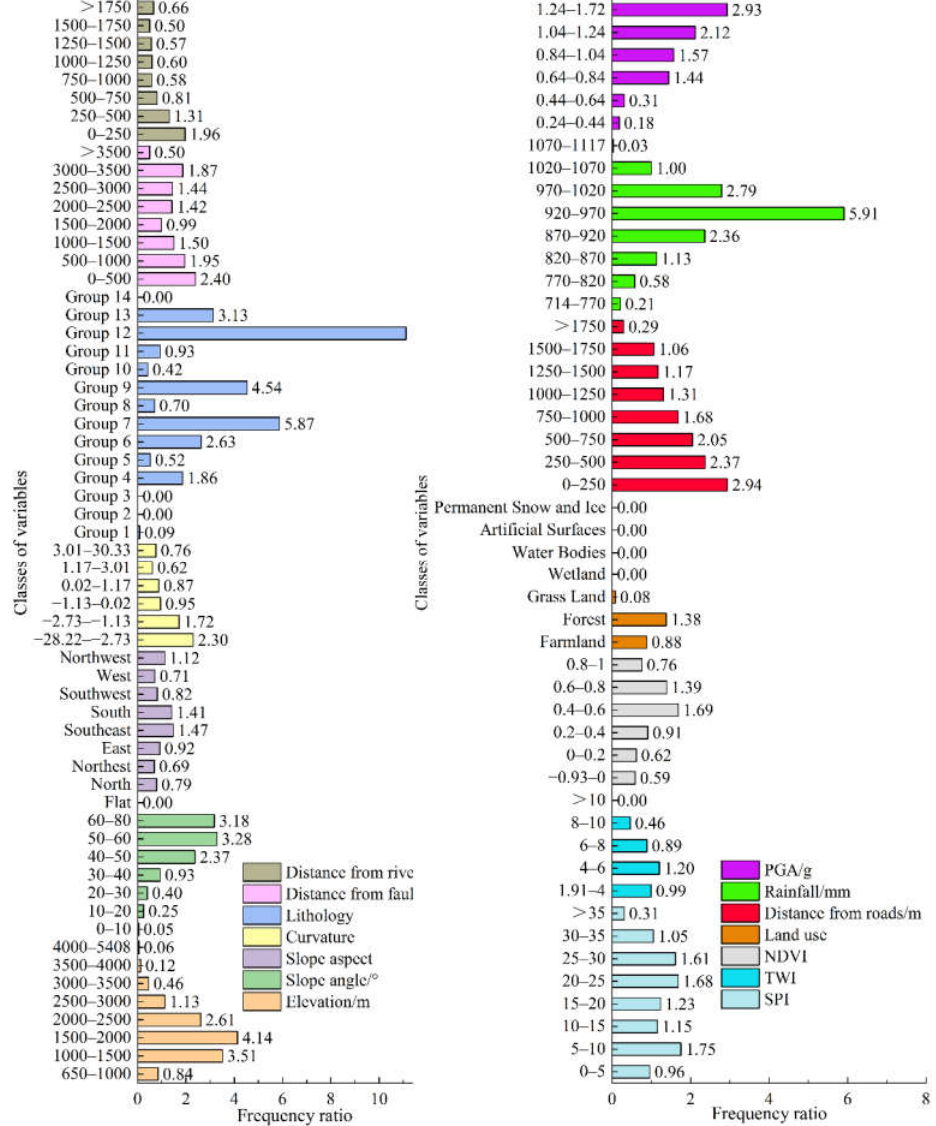
Figure 5. FR of the landslides occurring in each class of